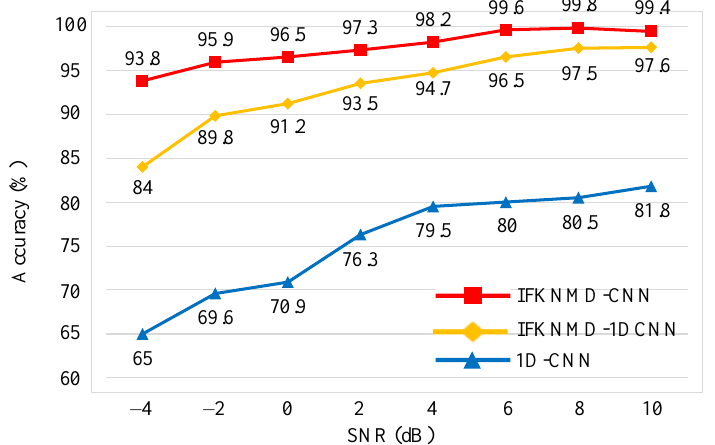
Figure 8. Noise test results with IFKNMD-CNN and comparison methods.